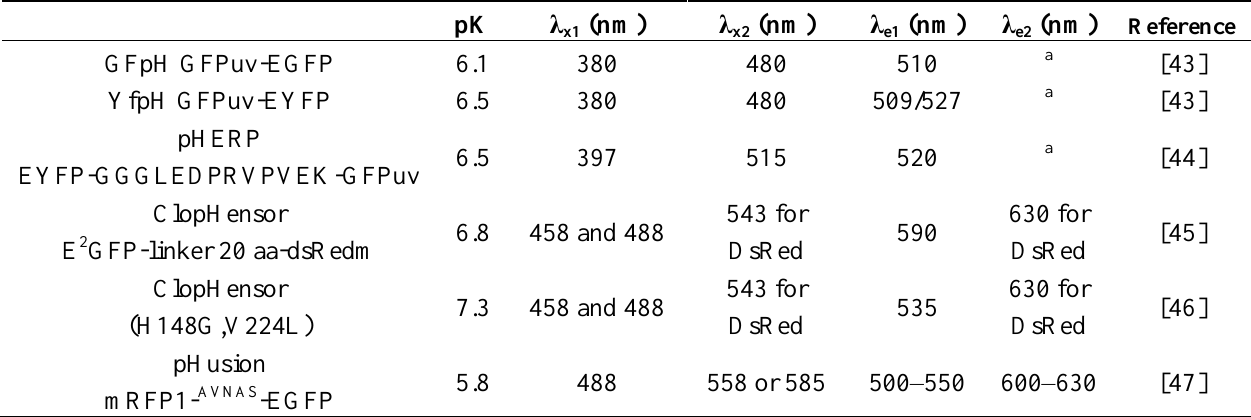
Table 3. pH-sensitive fluorescent